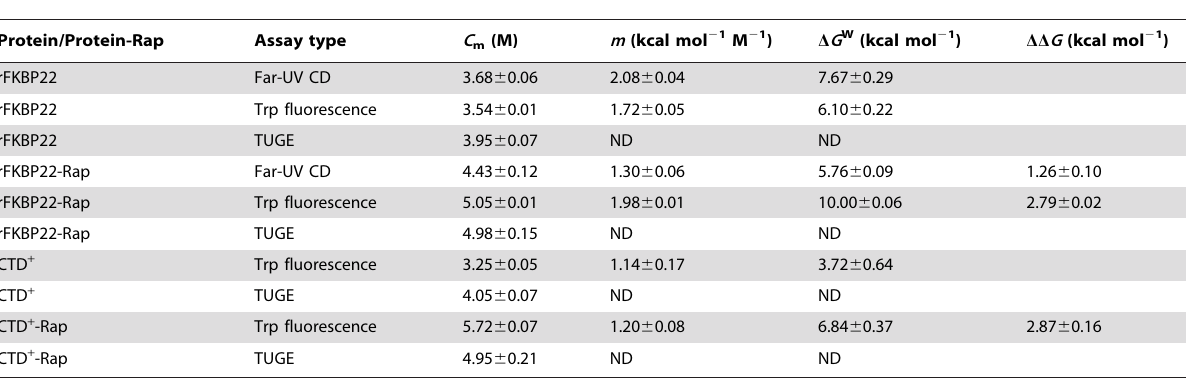
Table 1. Thermodynamic parameters of the urea-induced unfolding of proteins a .